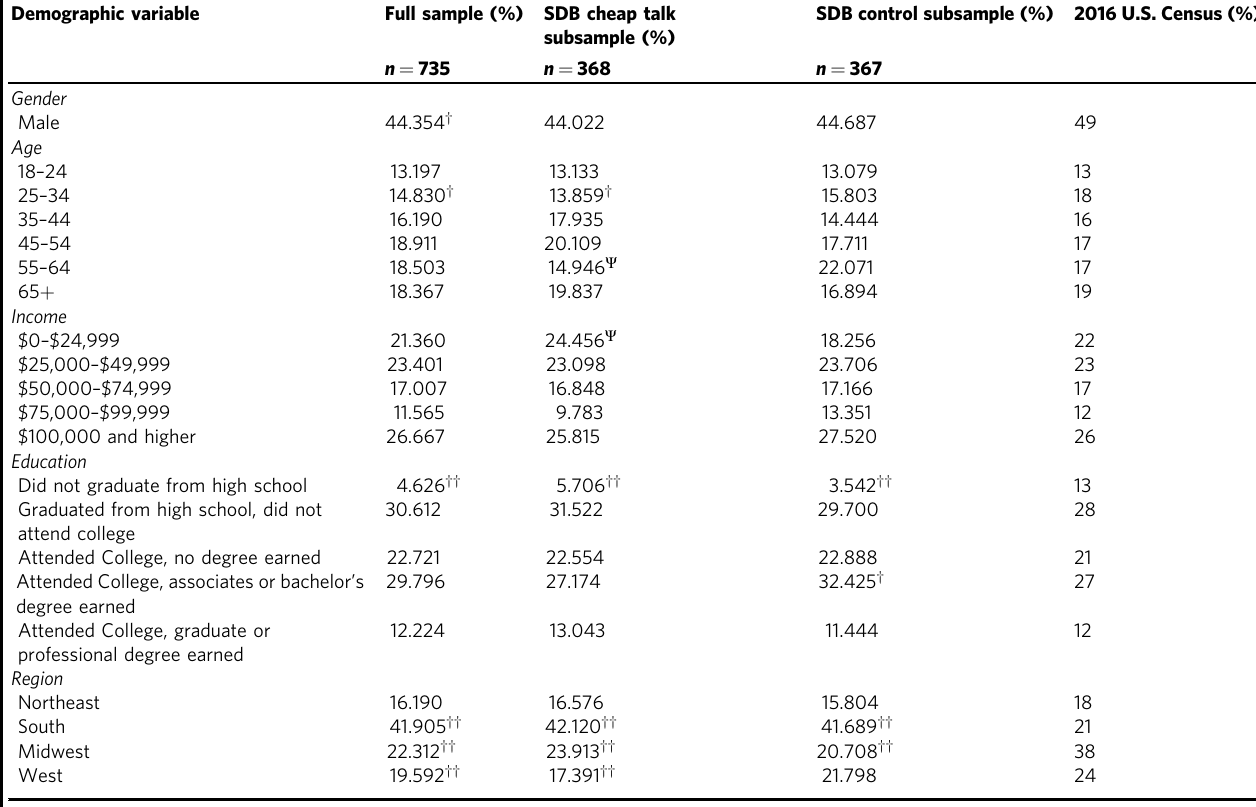
Table 1 Respondent demographics (with proportion of respondents compared against the U.S. census targeted demographics). Demographic